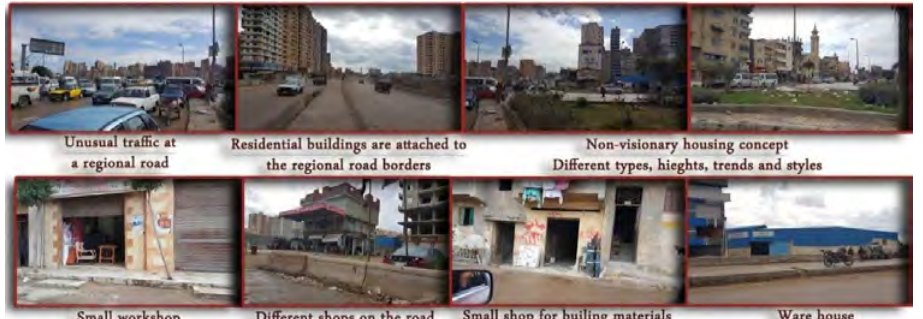
Figure 6. Facilities at the 45th Road (Yoseph, 2017)